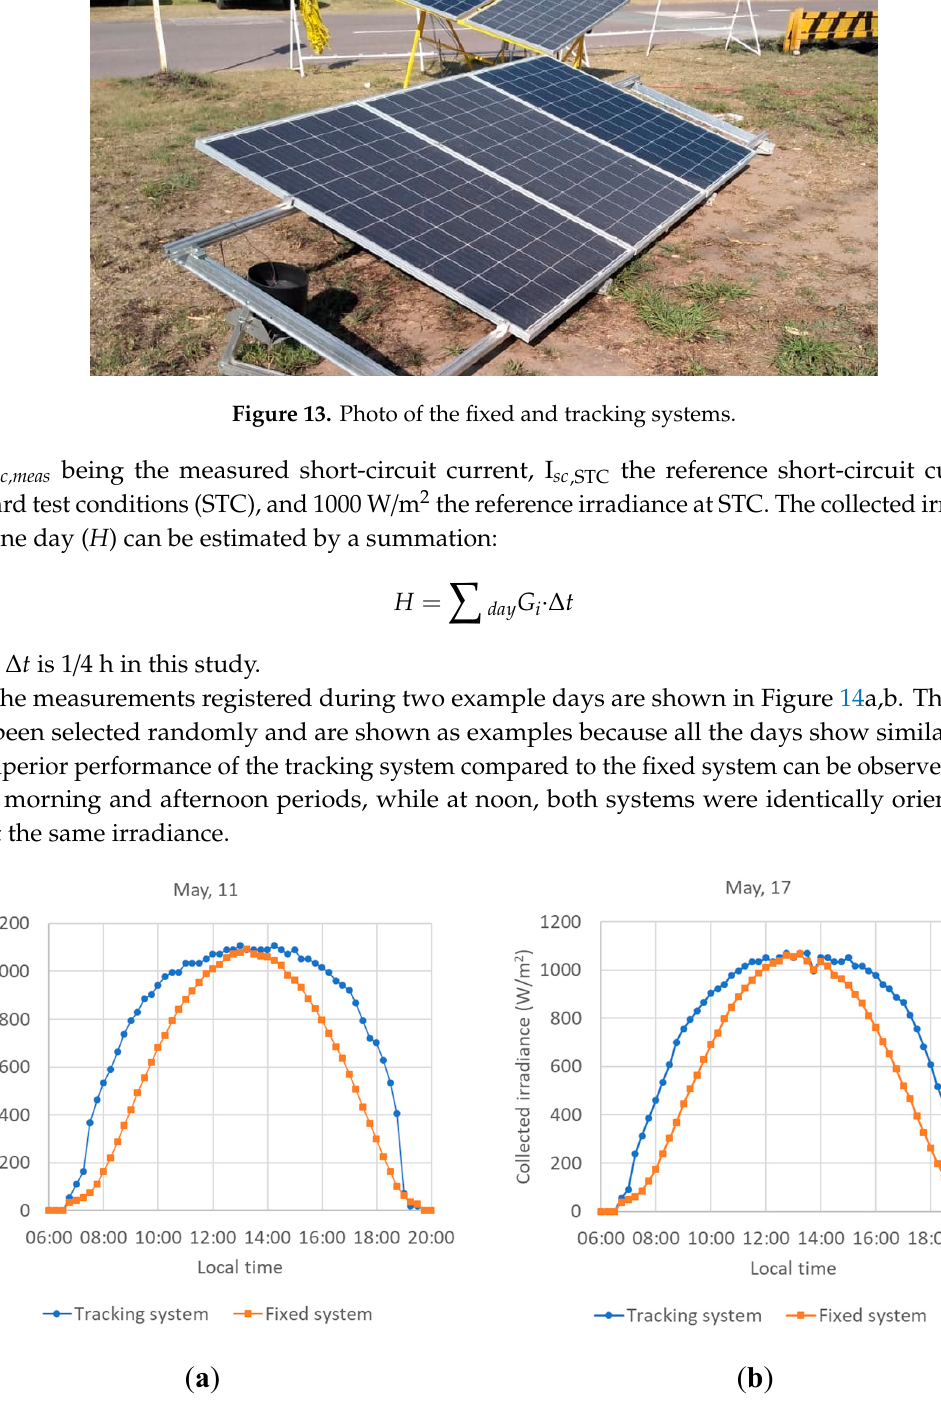
Figure 14. Irradiance measurements over May 11 ( a ) and May 17 ( b ) for the tracking and the fixed